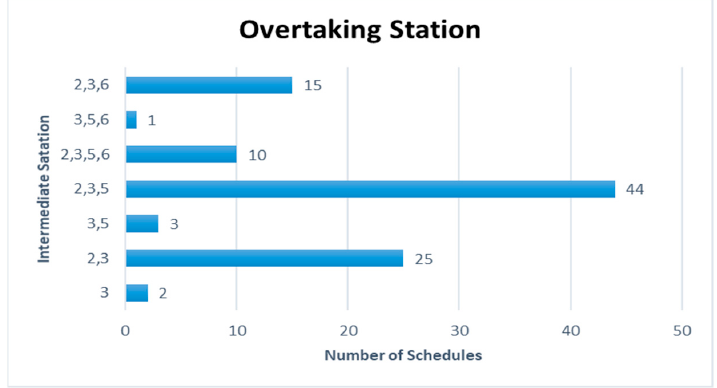
Figure 15. Overtaking Station for Case 3.